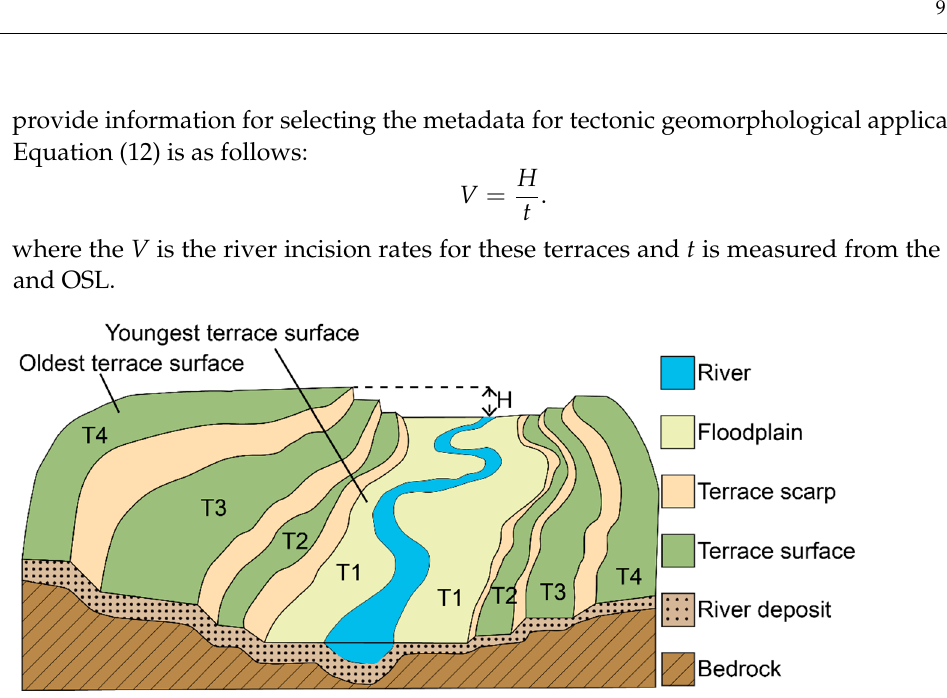
Figure 5. Schematic map of terrace incision rate, H is the terrace height from the river base flow level.